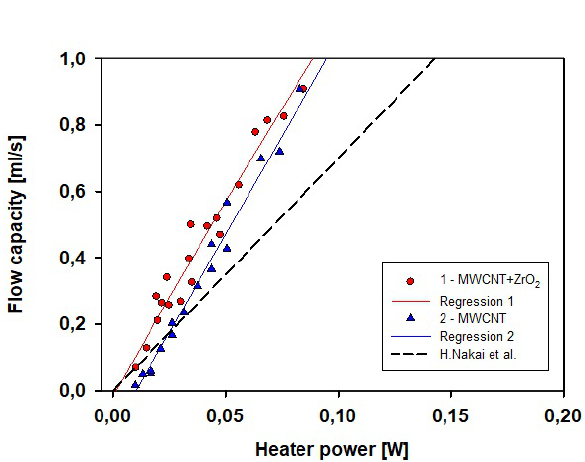
Figure 6. Filter flow capacity comparison with Nakai’s team results [13].